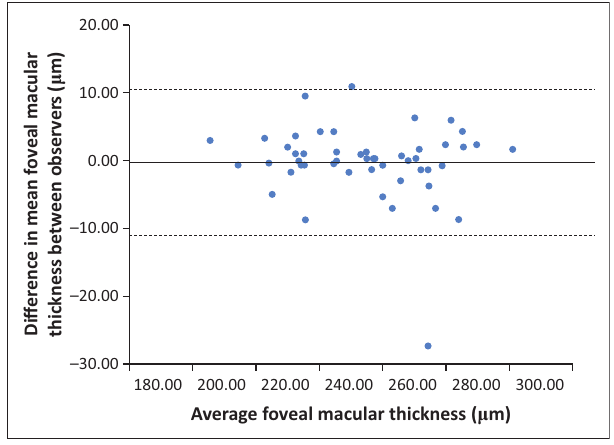
The solid line represents the X ‾ d (-0.227 µ m) and the dashed lines represent the upper and lower limits of agreement (see Table 2). An outlier near -30 µ m has resulted in the width (of limits of agreement) being almost 22 µ m. FIGURE 2: A Bland–Altman plot comparing iVue-100 macular thicknesses of the 50 right eyes taken by observers one and